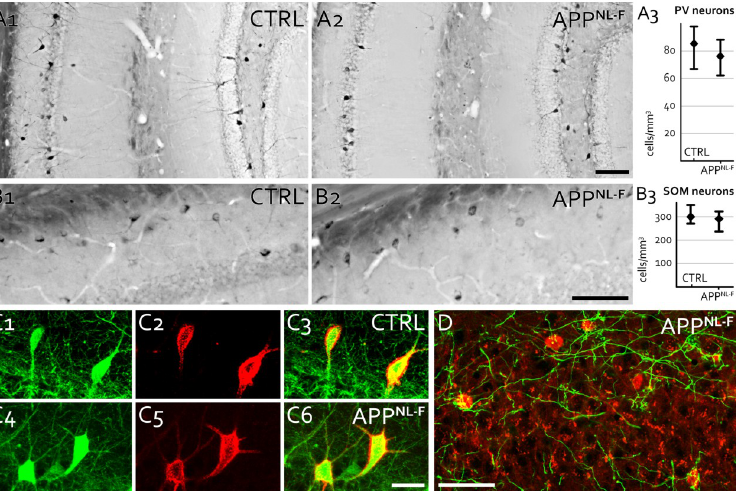
Fig 4. Investigation of local hippocampal interneurons in APP NL-F mice. A: Hippocampal PV INs of 18-month-old WT (CTRL, A1) and APP NL-F mice (A2). PV INs were labeled and counted using DAB immunolabeling in CA1-3 and dentate gyrus. No significant difference was found between genotypes (A3). Scale bar: 100 μ m. B: Hippocampal SOM INs of 18-month-old control (CTRL, B1) and APP NL-F mice (B2). SOM INs were labeled and counted using DAB immunolabeling in CA1 stratum oriens. No significant difference was found between genotypes (B3). Scale bar: 50 μ m. C: PV INs (C1, C4, parvalbumin staining, green) are covered by perineuronal nets (C2-3, C5-6, PNN staining, red) both in 21-month-old WT (CTRL, C1-3) and APP NL-F mice (C4-6). Scale bar: 25 μ m. D: Virally traced septo- hippocampal PV positive input fibers (green) seem healthy and target local hippocampal PV INs (red) abundantly in 18-month-old APP NL-F mice. Scale bar: 50 μ